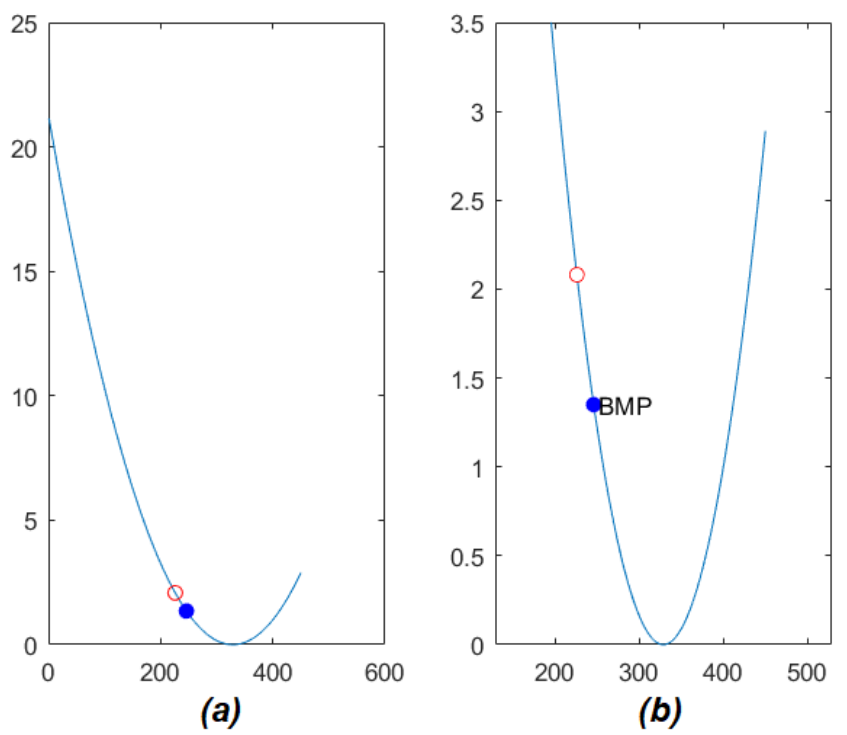
Figure 5. Example of matching by using the approach in [20] ( a ) and detail near the vertex of the φ function (see Equation (4)). The red circle is the point on φ with the same x as the point on the ( b ). The blue point represents the value of φ corresponding to the Best Matching Point (BMP) according to the